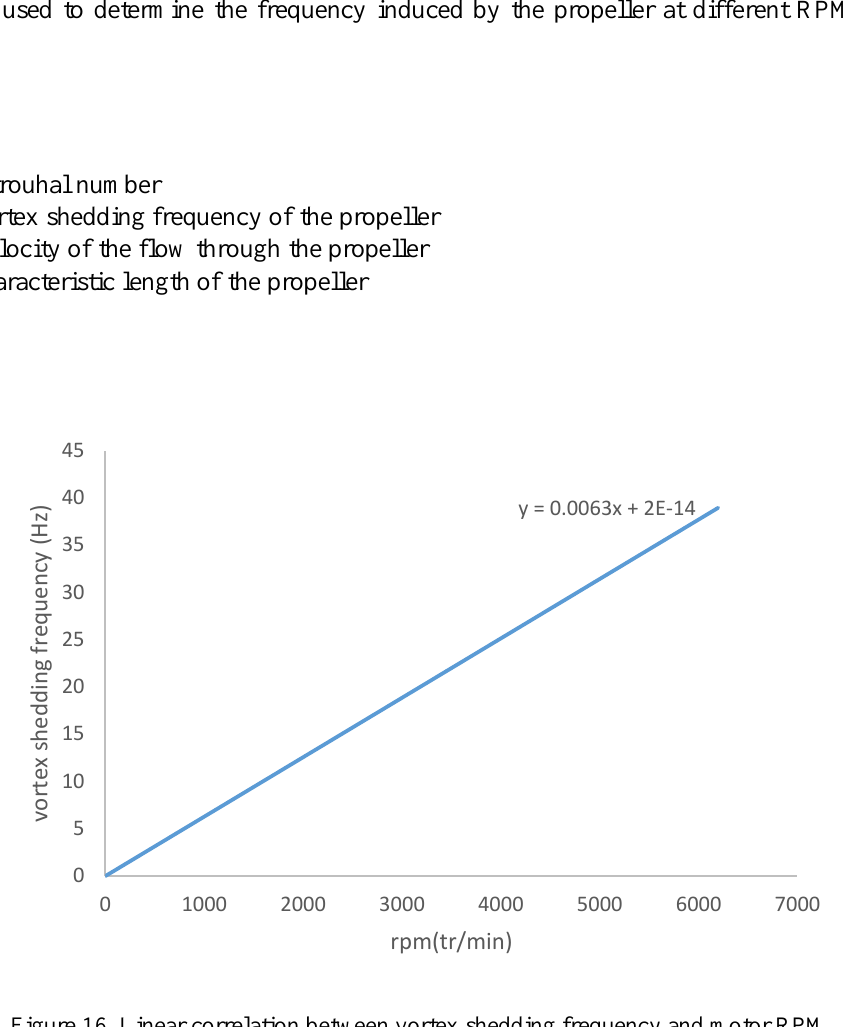
Figure 16. Linear correlation between vortex shedding frequency and motor